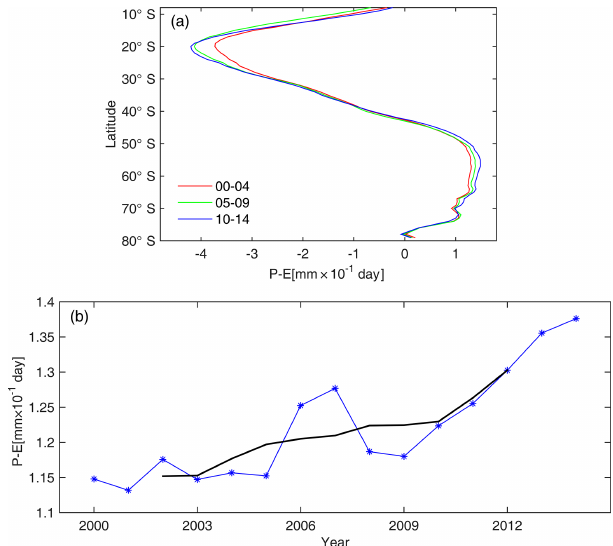
Figure 4. Calculated from ERA-Interim precipitation and evapora- tion data: (a) zonal mean (ocean areas only) of annual P − E (fresh- water input, mmday − 1 ) ; each line represents a 5-year averaged re- sult. The corresponding time period (i.e. 00–04 for 2000–2004) is listed in the bottom-left corner. (b) Time series of annually P − E , averaged over the oceans in 45–65 ◦ S, 0–360 ◦ E band from 2000 to 2014 (blue star), and its 5-year running mean